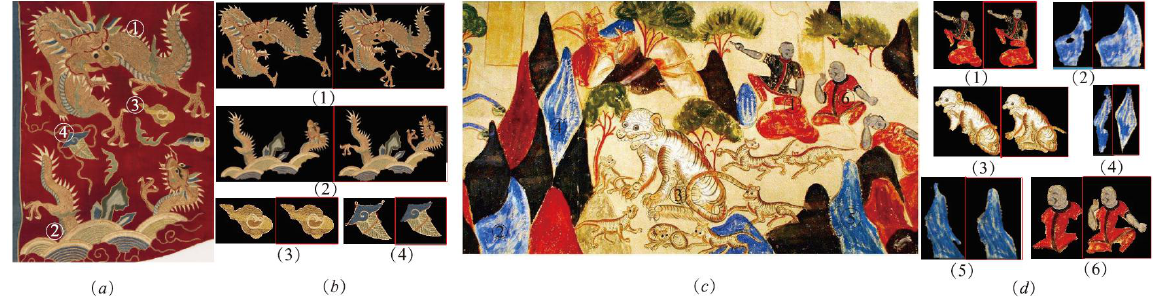
Fig. 4. Comparison of segmentation results on the CGO dataset with the different algorithms: (a) ethnic dress image, (c) art image, (b) and (d) are segmentation results with ER algorithm and the proposed algorithm (red border is the result in this